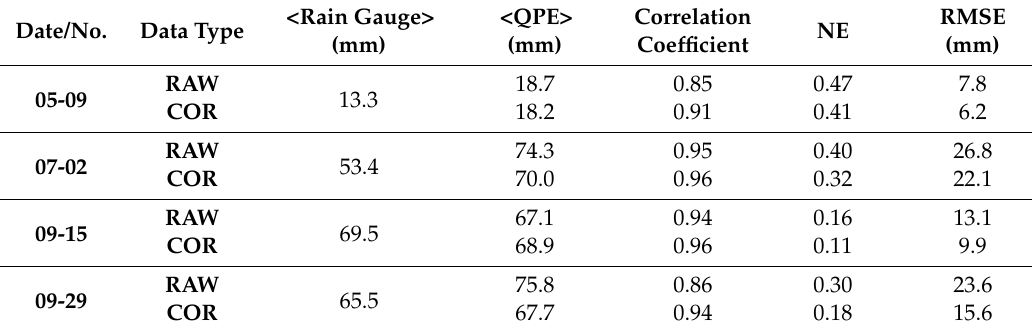
Table 3. Error statistics of 24 h accumulated